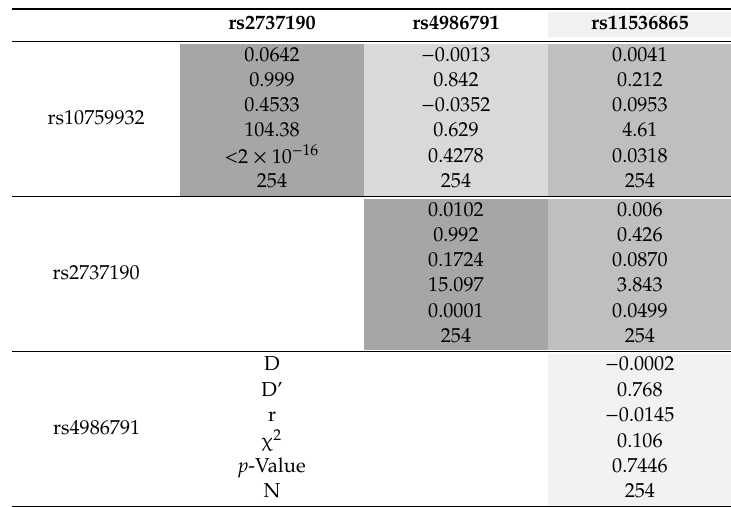
Table 6. Linkage disequilibrium analysis for TLR4 SNPs, GP vs. DEN.